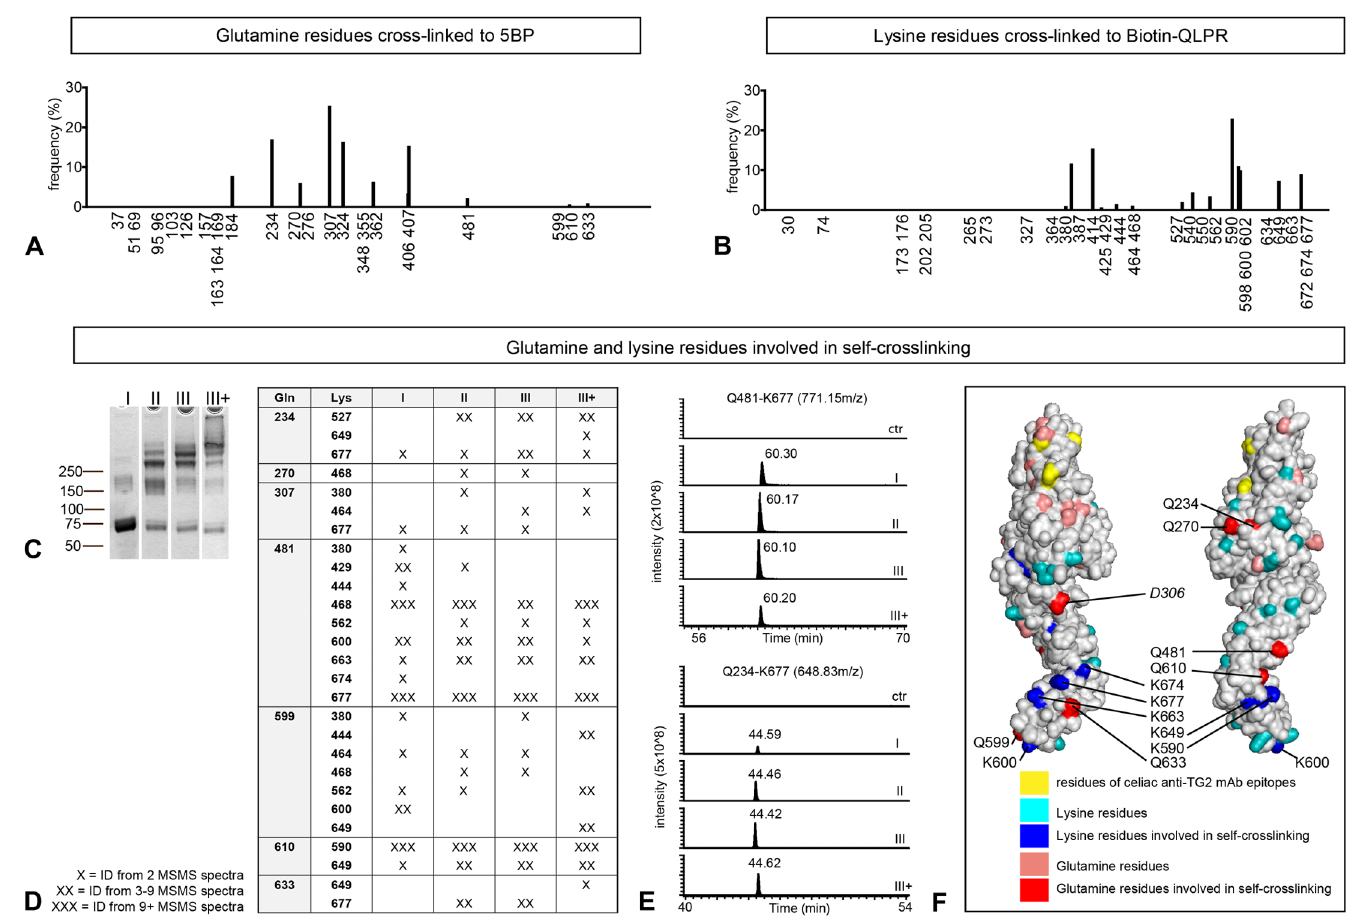
Fig 4. TG2-mediated self-crosslinking sites locate to the catalytic core and C-terminal part of TG2 (A) Glutamine residues of TG2 cross-linked to 5BP. The frequency (%) reflects the abundance of modified residues compared to each other. (B) Lysine residues of TG2 cross-linked to the small peptide Biotin- QLPR. Histograms in (A) and (B) are representative of two and three independent experiments, respectively. (D) Cross-linked peptide adducts identified from in solution tryptic digests of size separated fractions shown in (C). Multiple cross-linked peptide adducts were identified and only peptide adducts identified by two or more independent MSMS scans are listed in (D). Results from the second sample of triplicates are shown. (E) Extracted ion chromatogram for the peptide adducts Q481-K677 ( AVKGFR-VGQSMNMGSDFDVFAHITNNTAEEYVC(acetamide)R , 771.15 m/z; EIC window 771.15 – 771.25 m/z,) and Q234-K677 ( AVKGFR-VVSGMVNC(acetamide)NDDQGVLLGR ; 648.83m/z, EIC window 648.83 – 648.93m/z). Signal intensity (y-axis) reflects peptide abundance. (F) Location of glutamine and lysine residues in open conformation TG2 (PDB ID code 2Q3Z). Glutamine residues identified in cross-linked peptide adducts are shown in red, the remaining glutamine residues are shown in pink. Lysine residues identified in cross-linked peptide adducts are shown in blue, the remaining lysine residues are shown in turquoise. Residues E8, R19, K30 and D94, important for recognition of celiac anti-TG2 monoclonal antibodies [26], are shown in yellow. Q307 is not resolved in the crystal structure, and D306 (italics) is highlighted instead. K464 and K468 are also located in unresolved parts.